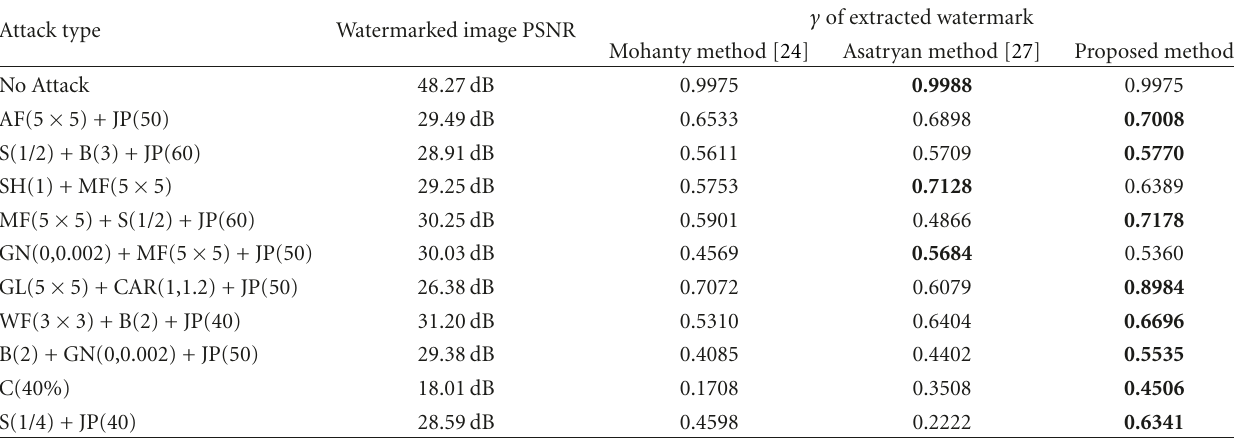
Table 7: The quality of extracted watermark from Lena image (512 × 512) with watermark size 256 × 256 (Figure 11(b)) versus several attacks in di ff erent methods.